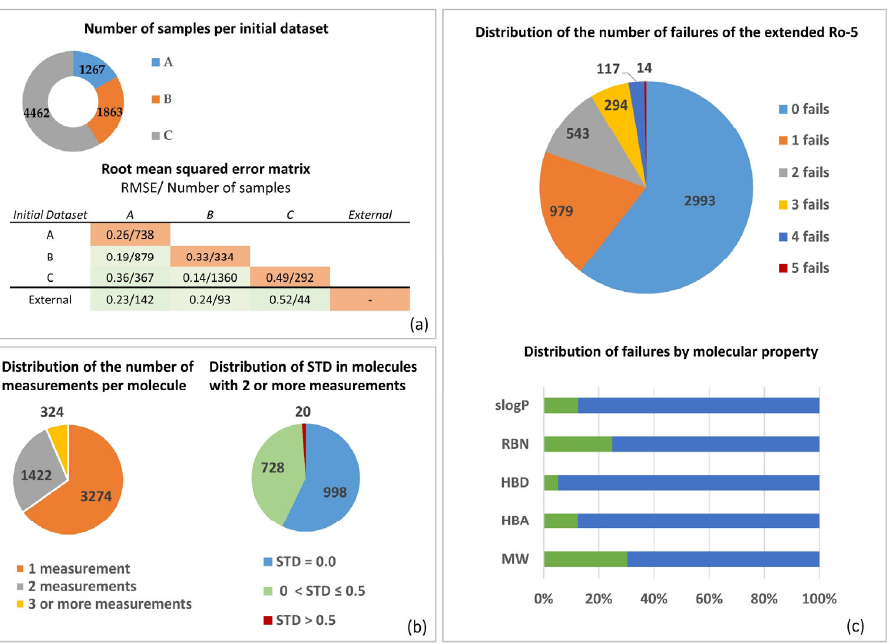
Figure 1. Exploration of MERGED Caco-2 permeability dataset: ( a ) Analysis of inter and intra overlapping of the individual curated Caco-2 permeability datasets with associated RMSE; ( b ) distribution with standard deviation (STD) of number of measures per molecule in the MERGED dataset; ( c ) distribution of extended rule ‐ of ‐ five number (Ro5) of failures in the MERGED data.